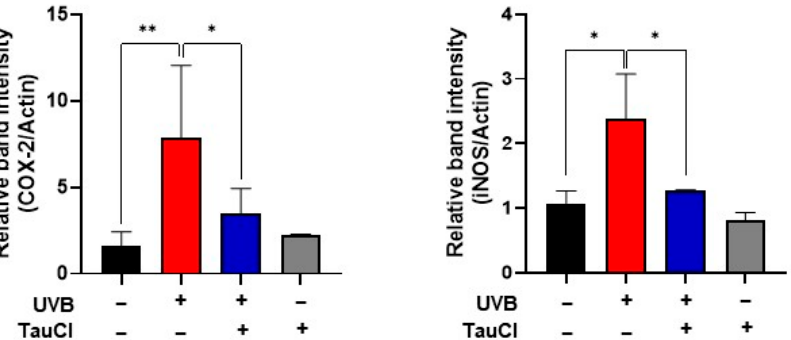
Figure 2. The expression of UVB-induced inflammatory enzymes was attenuated by topical application of TauCl. ( A ) Immunohistochemical analysis was performed for detecting COX-2 as described in Materials and Methods. ( B ) The expression levels of pro-inflammatory enzymes COX-2 and iNOS were measured by Western blot analysis of whole protein lysates. Actin was used as an equal loading control. Results are analyzed by one-way ANOVA and expressed as means ± SD ( n = 3 per group. * , ** Significantly different between groups compared (* p < 0.05; ** p < 0.01).